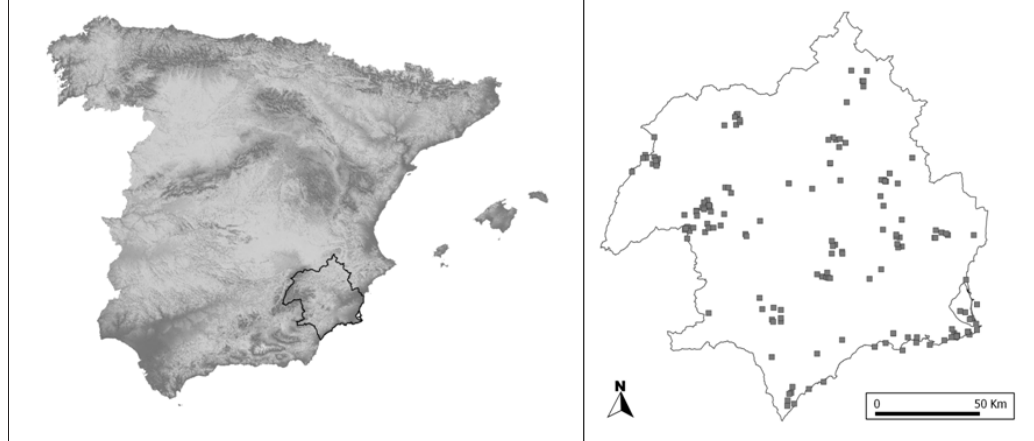
Fig 1 . Map of Spain with the Segura River Basin outlined (on the left) and a map of the Segura River Basin with the 163 localities sampled indicated with grey squares (on the